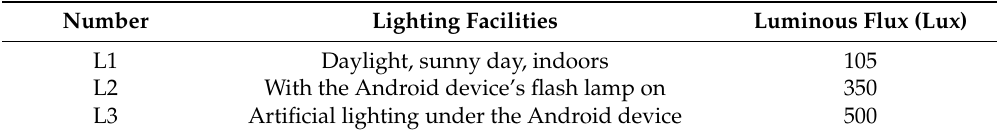
Table 1. The light conditions for measuring the accuracy of the segmentation algorithm. Number